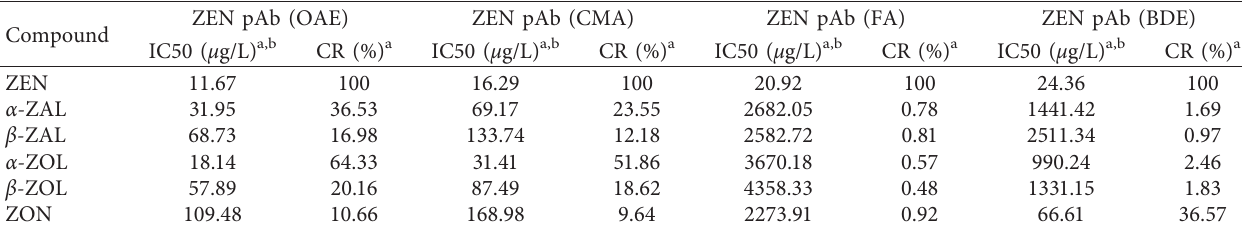
Table 3: The cross-reaction of ZEN pAb with ZEN and its analogs.